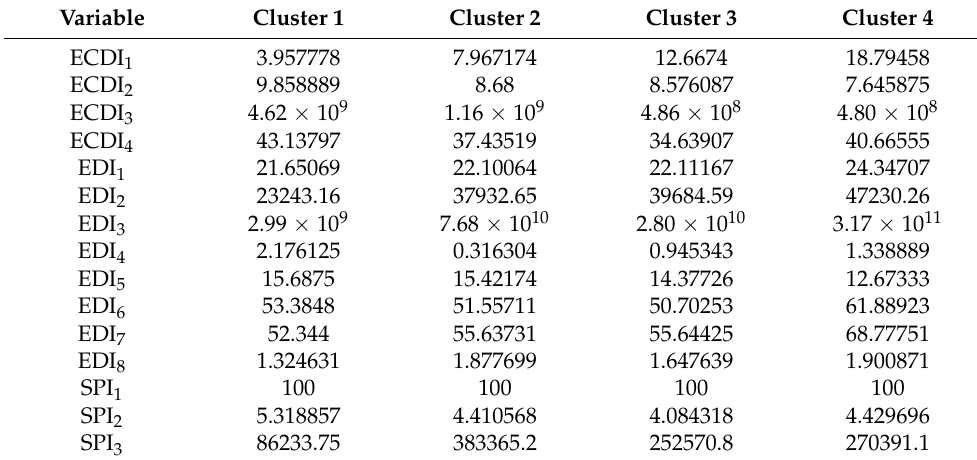
Table 9. Clustering of countries according to energy policy reform scenarios within the average values of input